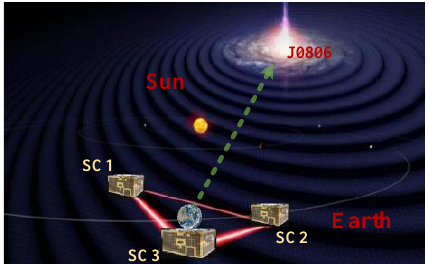
Figure 9. Schematic diagram of TianQin.